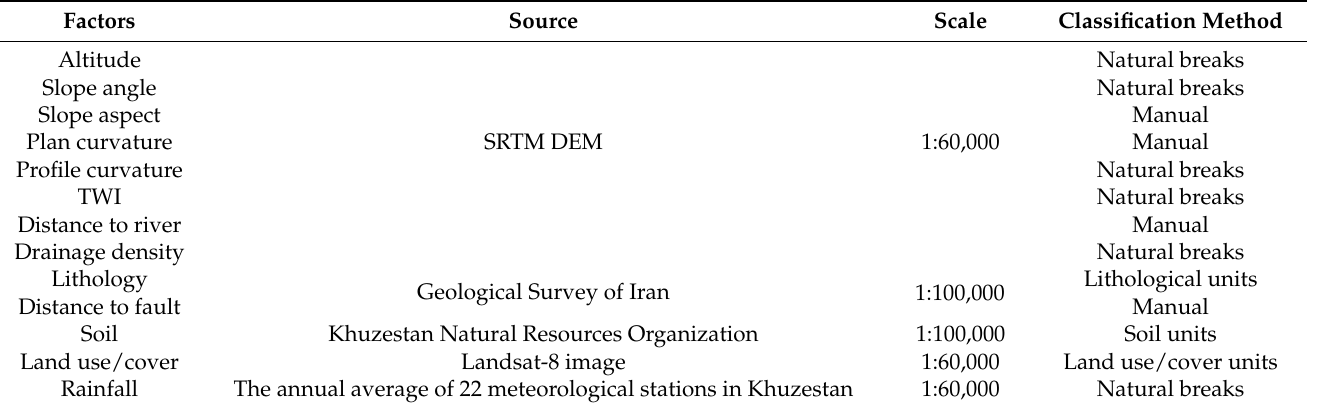
Table A1. Database of the conditioning